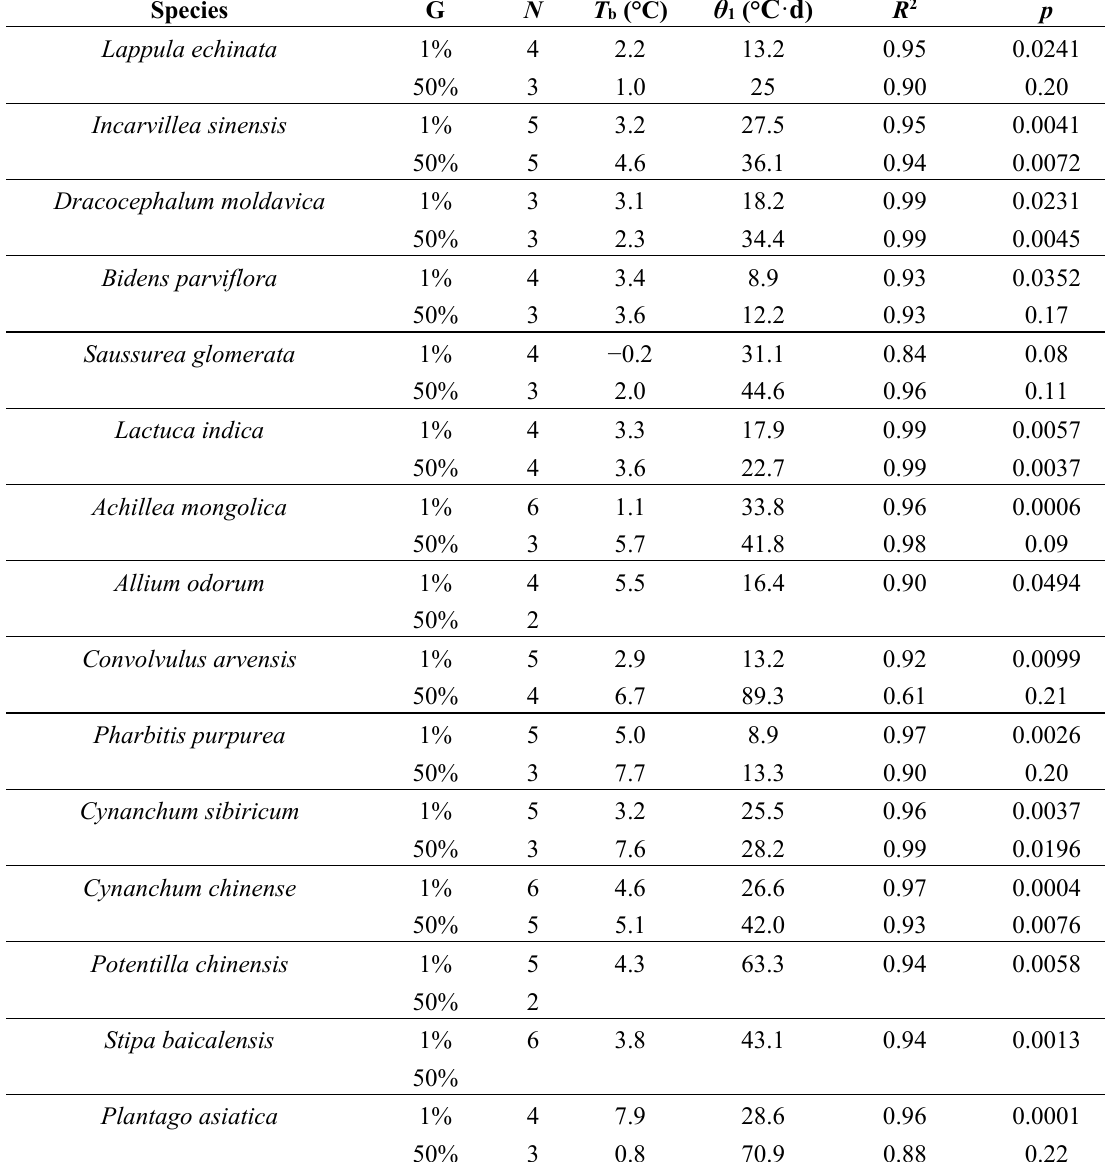
Table 3. Estimated parameters of thermal time model for 1% and 50% germination percentiles (G) of C 3 species at suboptimal